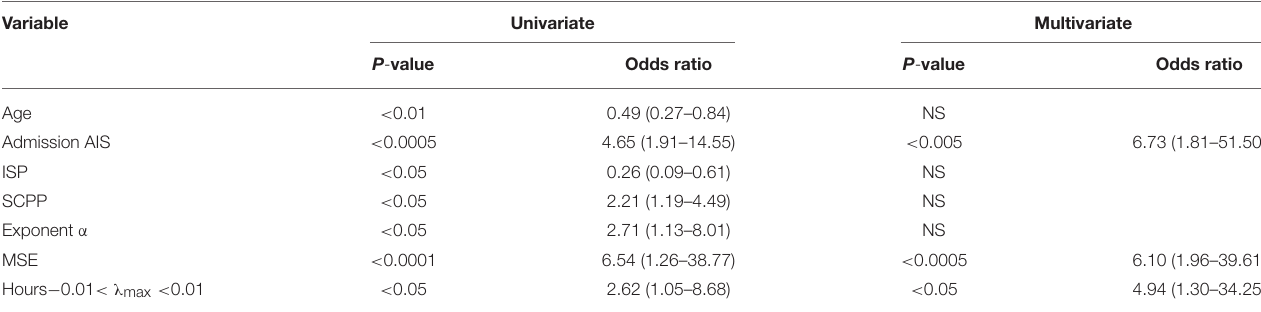
TABLE 2 | Univariate and multivariate logistic regression analysis.